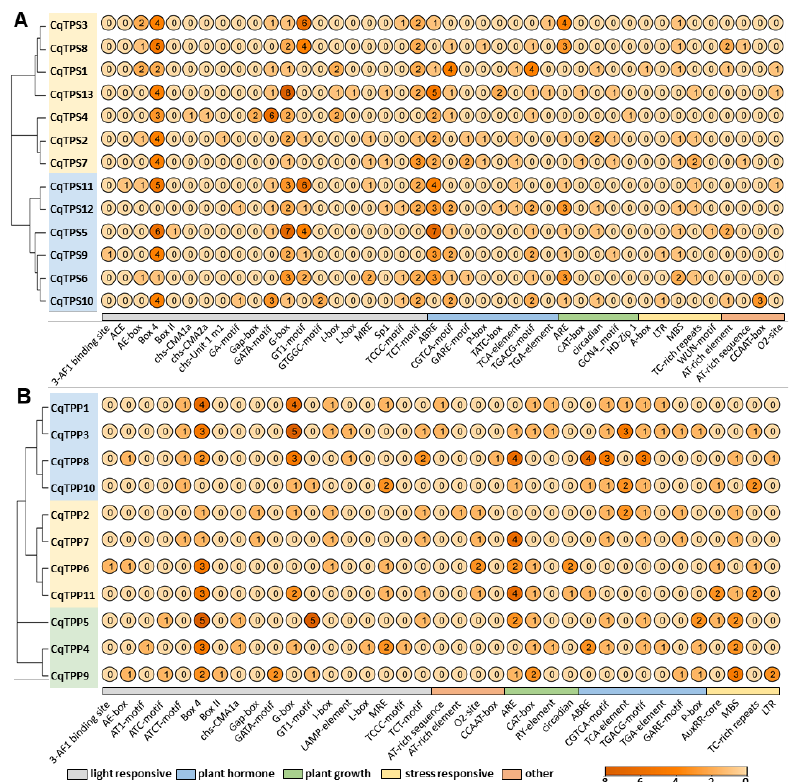
Figure 3. Analysis of cis-acting elements in promoters of CqTPS ( A ) and CqTPP ( B ) genes. The categorized groups are indicated by color bars. The number of each element is indicated in the circles and is also shown by different colors presented in a color scale in the lower